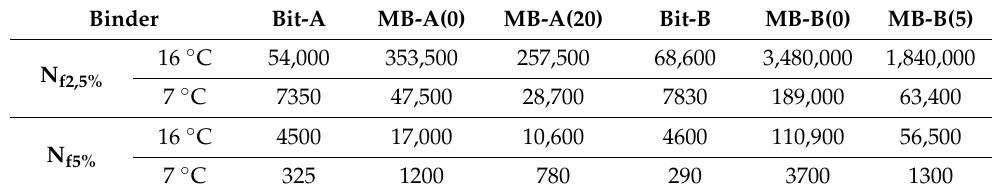
Table 6. LAS test results at temperatures 16 and 7 ◦ C: number of cycles to failure (N f ) (VECD analysis) at 2.5 and 5%